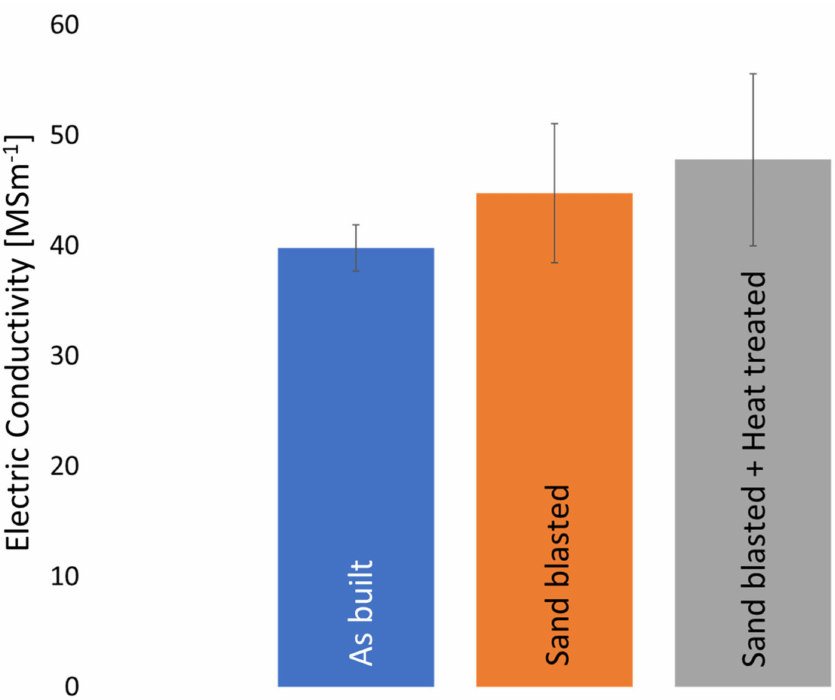
Figure 10. Measured electric conductivity of this